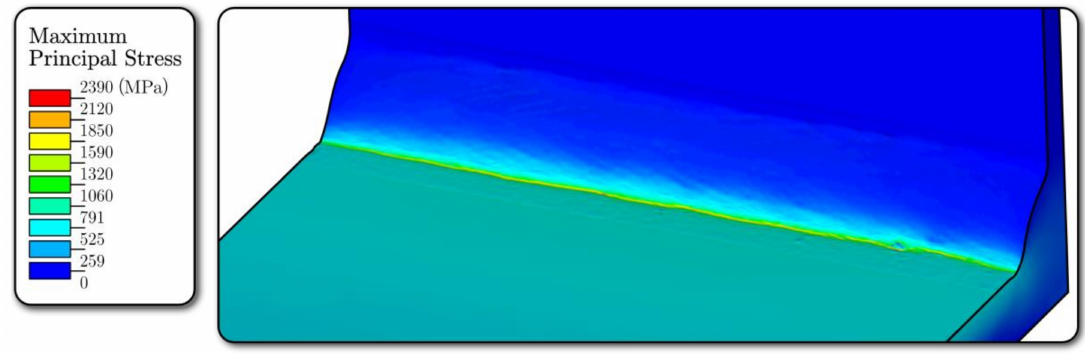
Figure 11. Stress distribution at the weld surface of the specimen 24 (failure order 17 in Table 1) for a nominal stress of 180